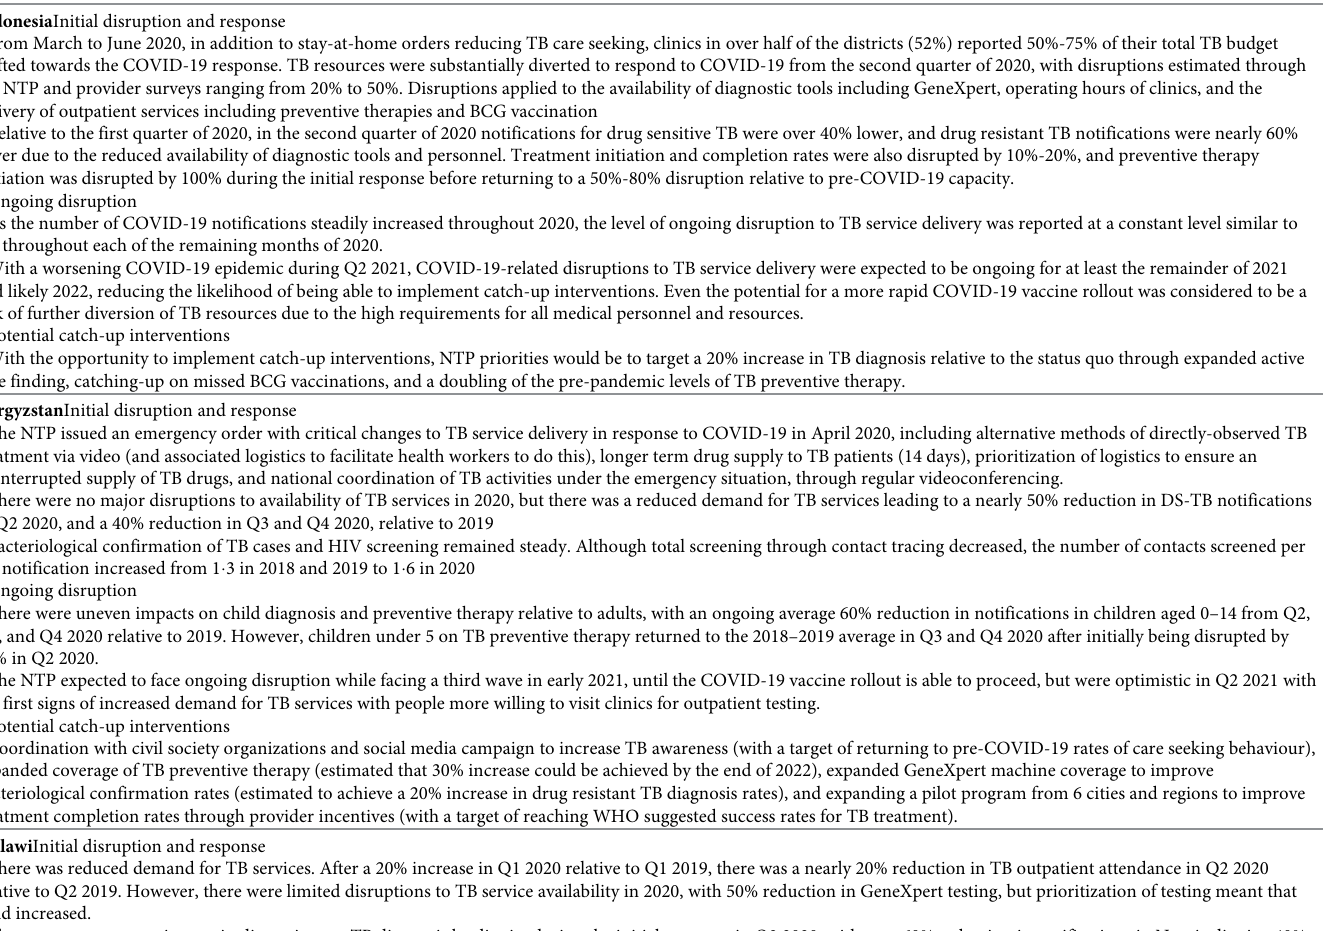
Table 2. Summary of COVID-19-related TB service disruptions as reported by respective National TB